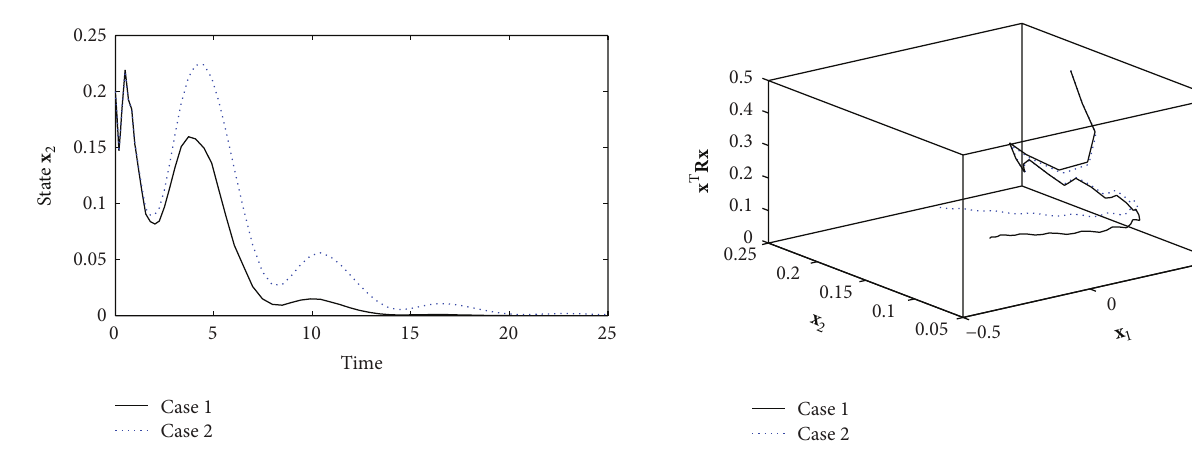
Figure 3: The trajectories of the controlled system state x 2 (𝑡) .